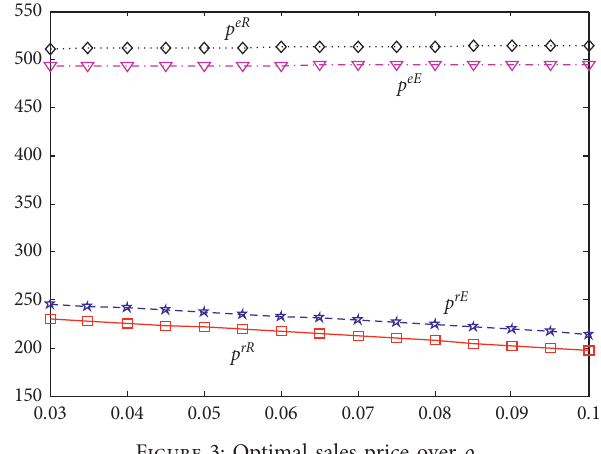
Figure 3: Optimal sales price over ρ .